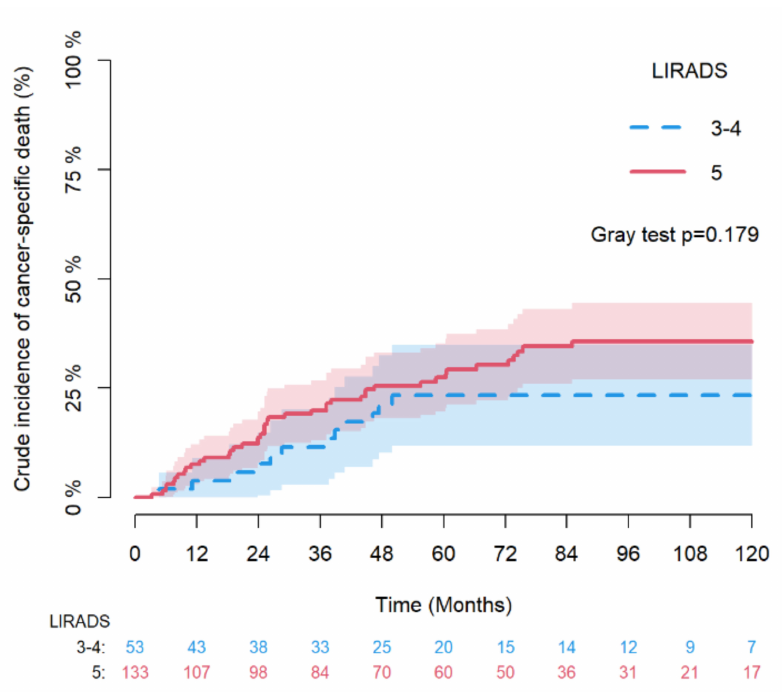
Figure 4. Aalen–Johansen crude incidence estimates of cancer-specific death with Gray test (death for other causes as competing risk) by LR-3/4 vs